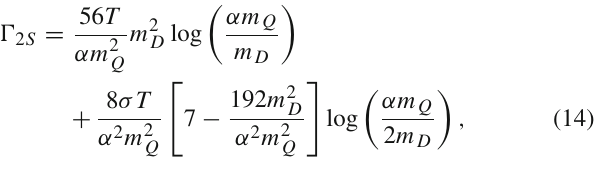
The dissociation temperature for the quarkonium states can be determined by using the conservative quantitative con- dissociation temperature of that particular quarkonia state having principal quantum number n and azimuthal quantum number l